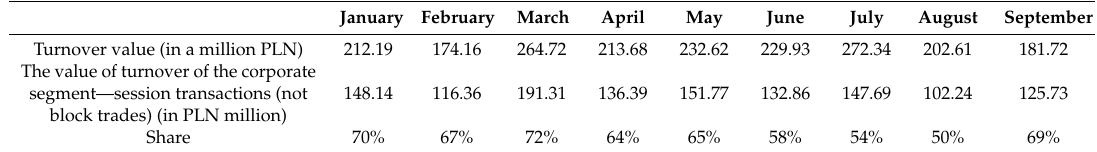
Table 5. Catalyst market in